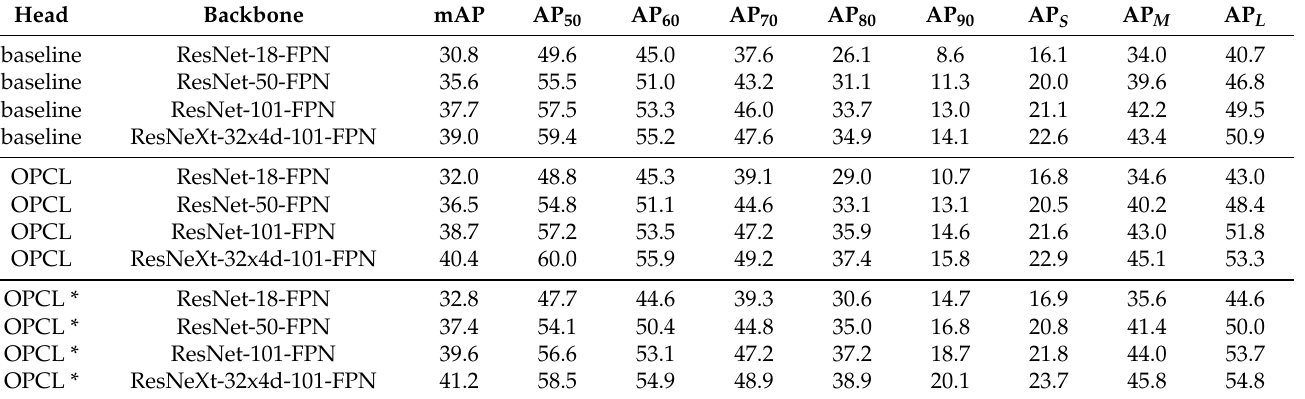
Table 6. Experimental results on MS COCO. All the models were trained on COCO trainval and evaluated on COCO val-2017 with the image scale of [800, 1333]. All the other settings were adopted as the same as the default settings provided in the MMDetection. The symbol “*” means the gradient of OPCL with respect to IoU was computed during